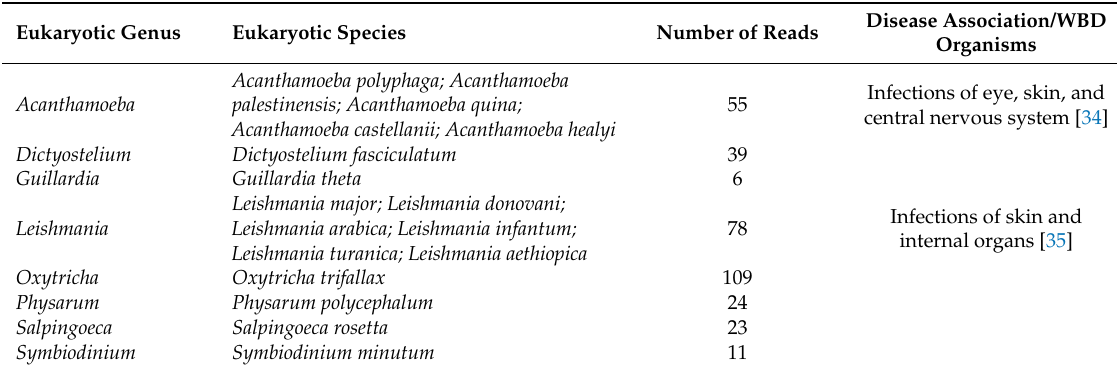
Table 1. List of eukaryotic microbial genus and species, some of which are pathogenic, identified in the Little Bighorn River metagenome (DNA prepared without selection). WBD (waterborne disease) organisms have a known association with human disease.